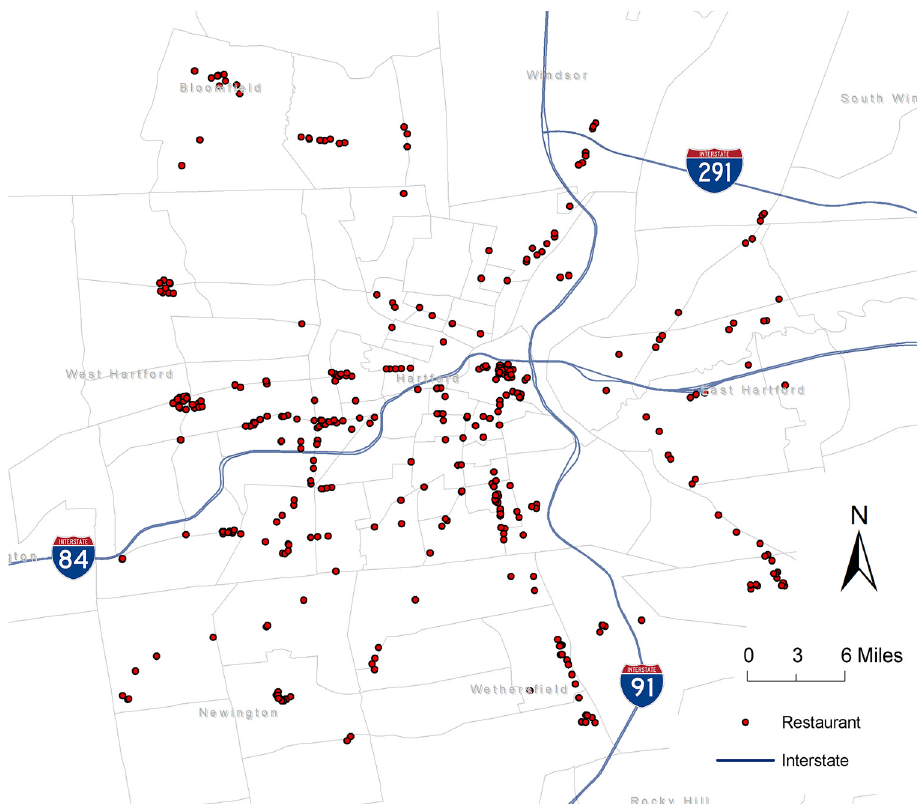
Figure 1. Spatial distribution of restaurants in the Greater Hartford region.